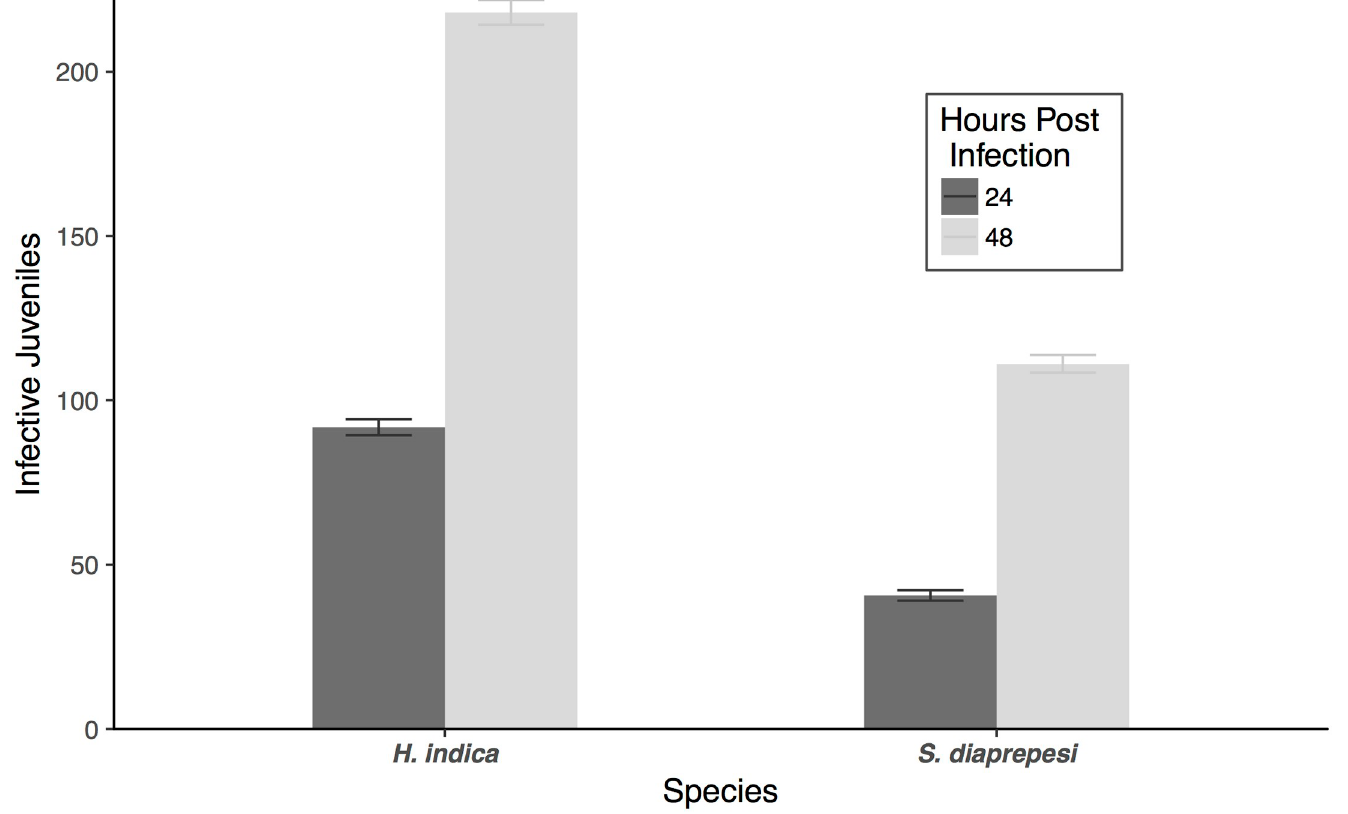
Fig 1. Baseline infection. Number of entomopathogenic nematode infective juveniles recovered from G. mellonella larvae. Bars and error bars denote means and 95% confidence intervals respectively.